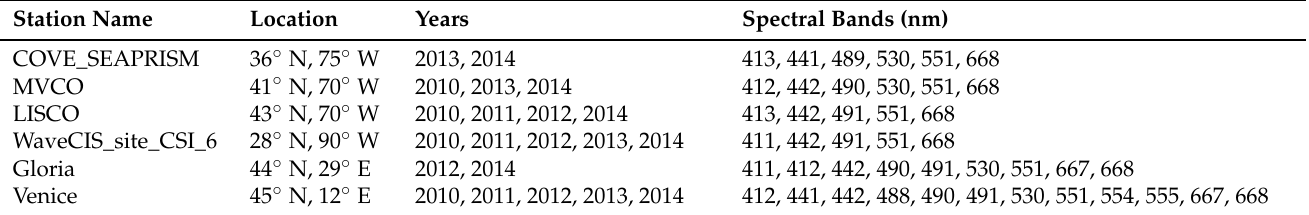
Figure 1. True-colour image composites of HICO Level 1B data at AERONET-OC sites and Pensacola Bay. Red circles show the location of the AERONET-OC and sampling stations. Table 1. AERONET-OC sites and corresponding data used in this